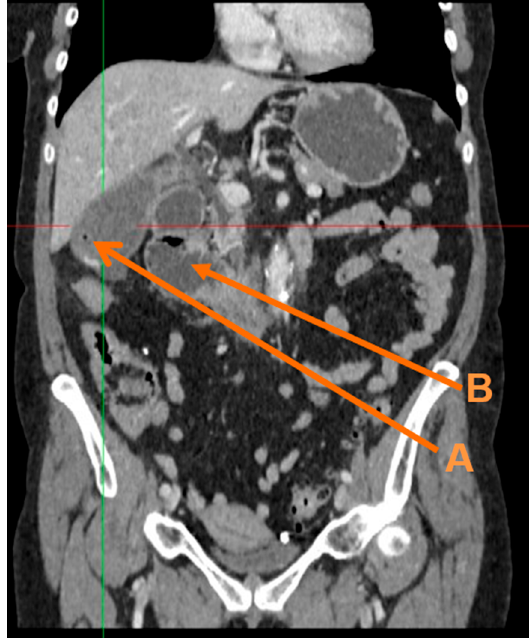
Figure 1 . Coronal computerised tomography (CT) reconstruction showing: ( A ) Gas in the gallbladder, and ( B ) localised duodenal ileus.